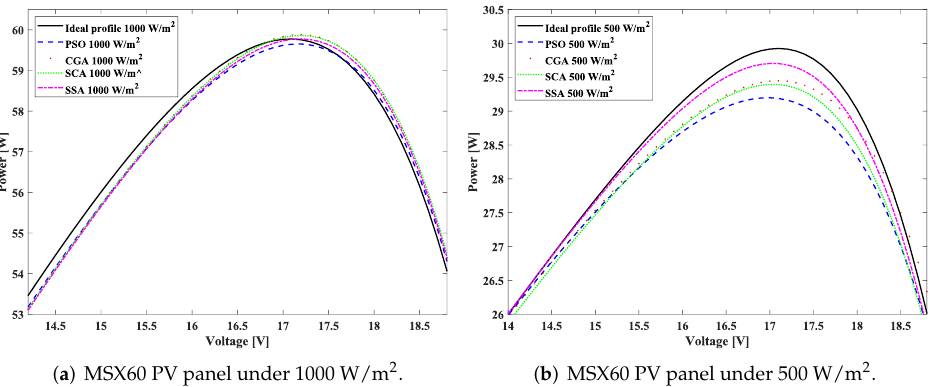
Figure 9. Zoom-ins on the simulation performed with the parameters found for the lowest errors in the MSX60 PV panel.